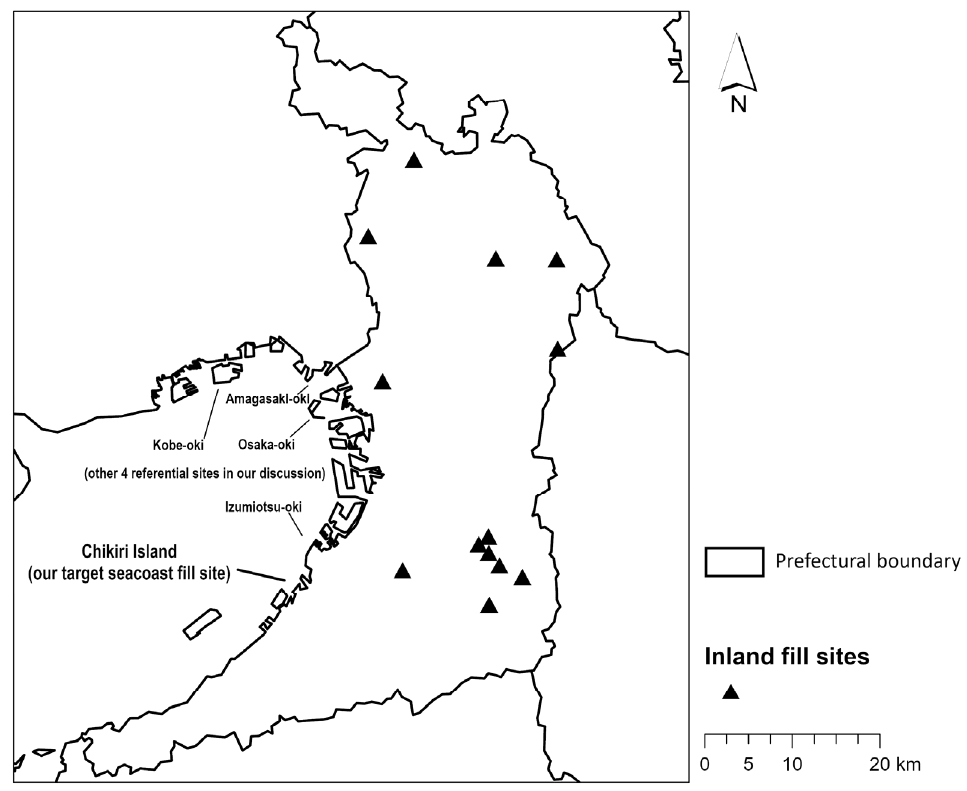
Figure 3. The overall distribution of our target fill sites.